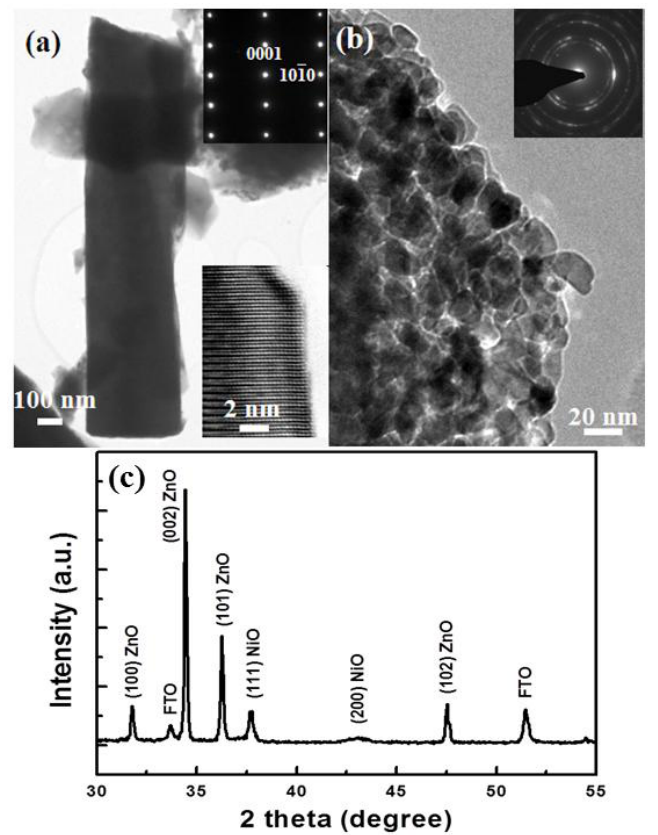
Figure 2. ( a,b ) TEM images with corresponding selected area electron diffraction (SAED) patterns of ZnO NR and NiO, respectively; ( c ) X-ray diffraction pattern for composite nanostructures of